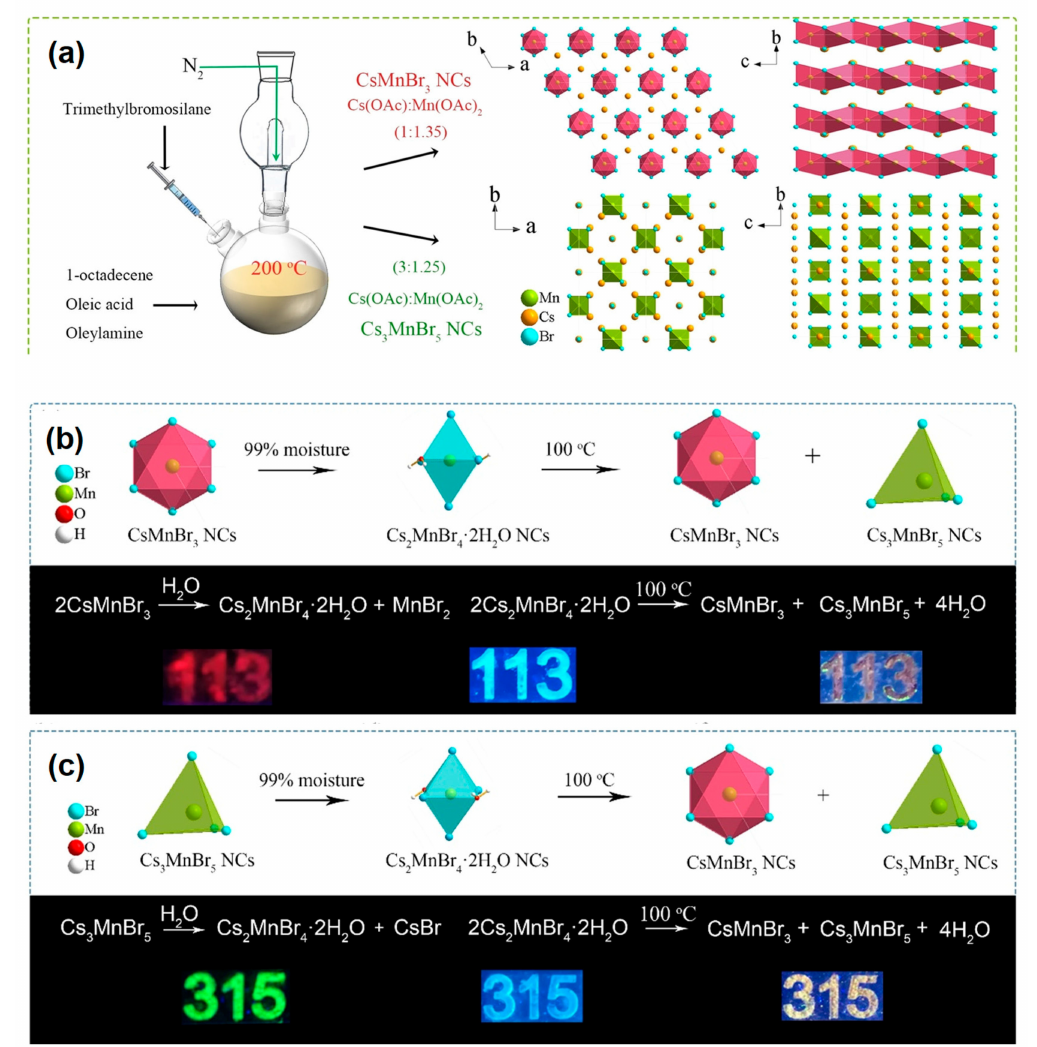
Figure 5. ( a ) Synthesis process for CsMnBr 3 and Cs 3 MnBr 5 and their crystal structures, respectively. ( b ) Transformation of CsMnBr 3 to Cs 2 MnBr 4 · 2H 2 O in moisture (99%) and further transformation by dehydration to CsMnBr 3 and Cs 3 MnBr 5 . ( c ) Transformation of Cs 3 MnBr 5 to Cs 2 MnBr 4 · 2H 2 O in moisture (99%) and further transformation by dehydration to CsMnBr 3 and Cs 3 MnBr 5 . Reproduced with permission from [35], Copyright 2021,